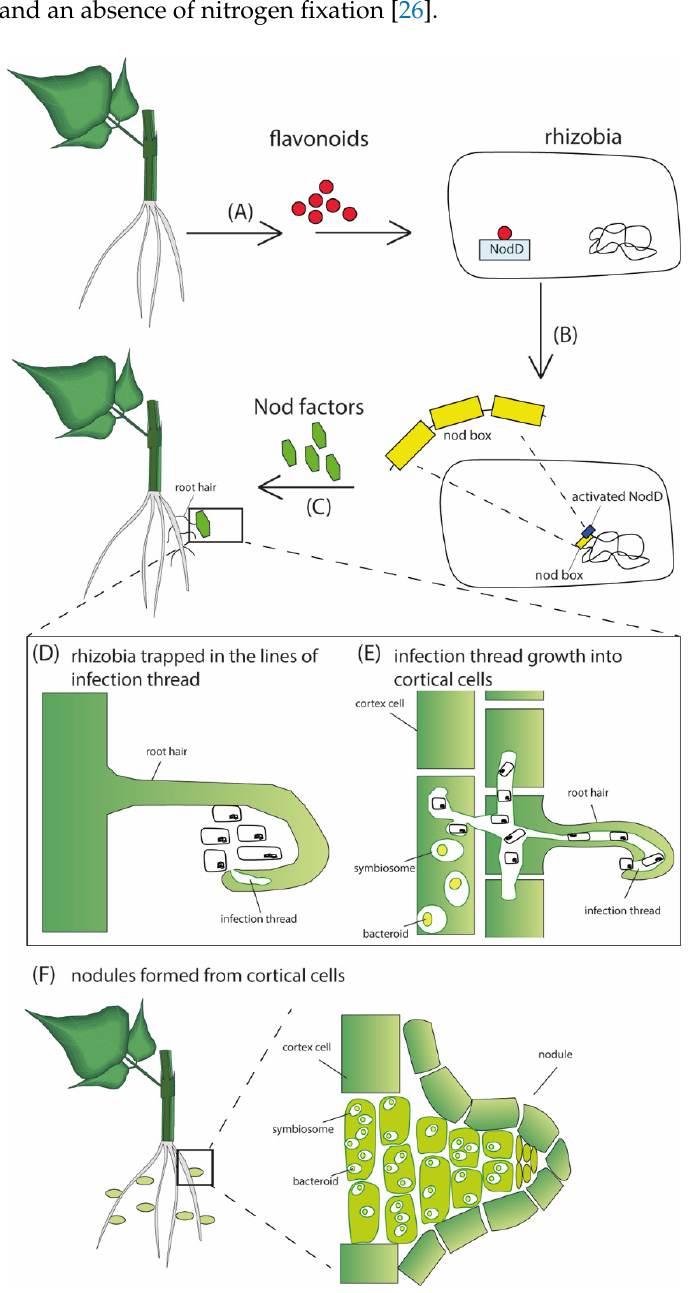
Figure 1. A schematic representation of the nodulation process. ( A ) Host plant releases flavonoids into the rhizosphere that are perceived by specific rhizobia. The flavonoids induce transcription of the genes for biosynthesis of the rhizobial Nod factors, which the plant perceives to allow symbiotic infection of the root. After transcription, the activated NodD binds to the nod box promoter ( B ), inducing the transcription and synthesis of Nod factors ( C ). The Nod factors induce the development of the infection thread that traps rhizobia within the curled surfaces ( D ). The infection thread grows through epidermal cells into the cortical cells, where rhizobia are released and internalized by the cortical cells ( E ). Further proliferation and differentiation of both bacteria and infected cortical cells results in nodule formation ( F ).